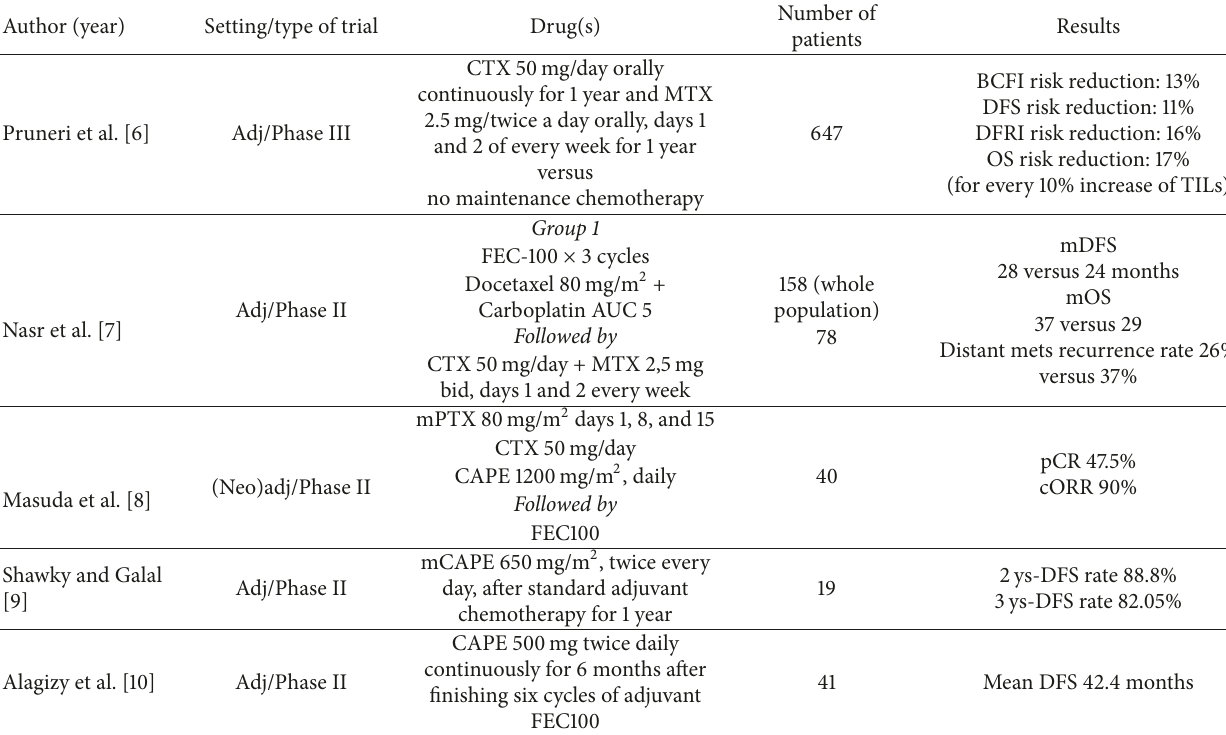
Table 1: Summary of data in the (neo)adjuvant